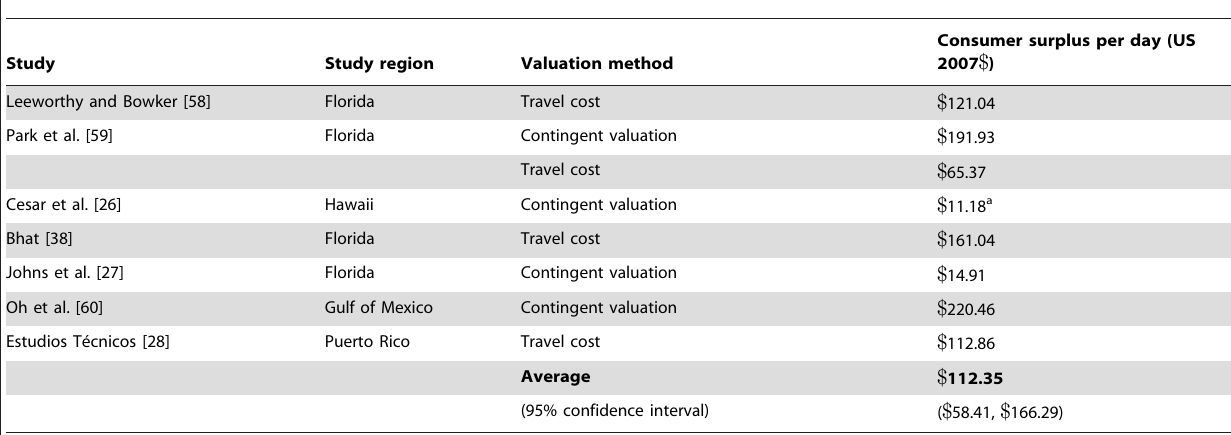
Table 2. Review of estimated snorkeling and diving recreational